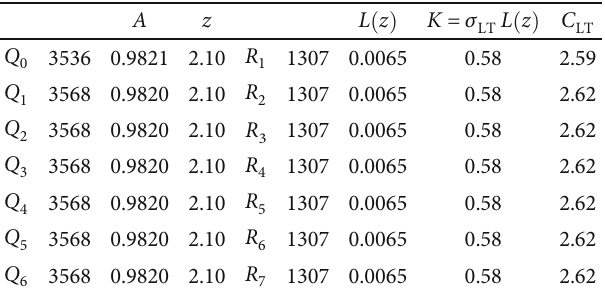
Table 9: Results of the ( Q , R ) model with SD criteria.